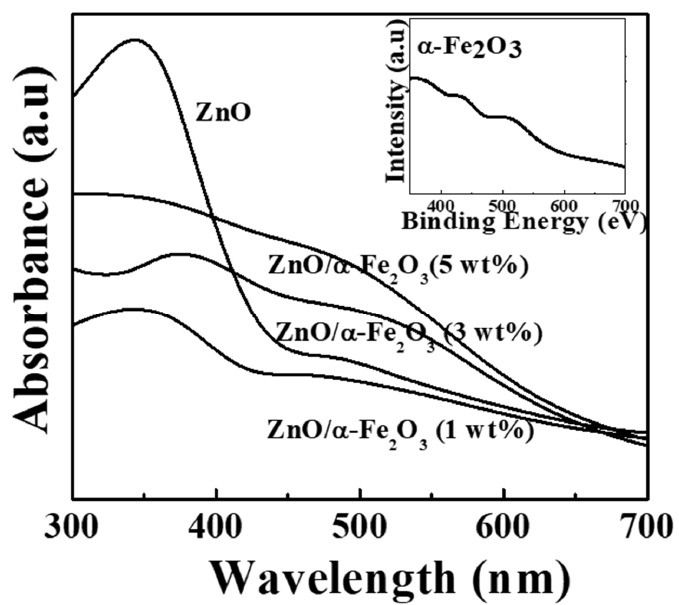
Figure 4. UV-vis spectra of ( a ) ZnO; ( b ) ZnO / α -Fe 2 O 3 (1 wt%); ( c ) ZnO / α -Fe 2 O 3 (3 wt%); and ( d ) ZnO / α -Fe 2 O 3 (5 wt%).